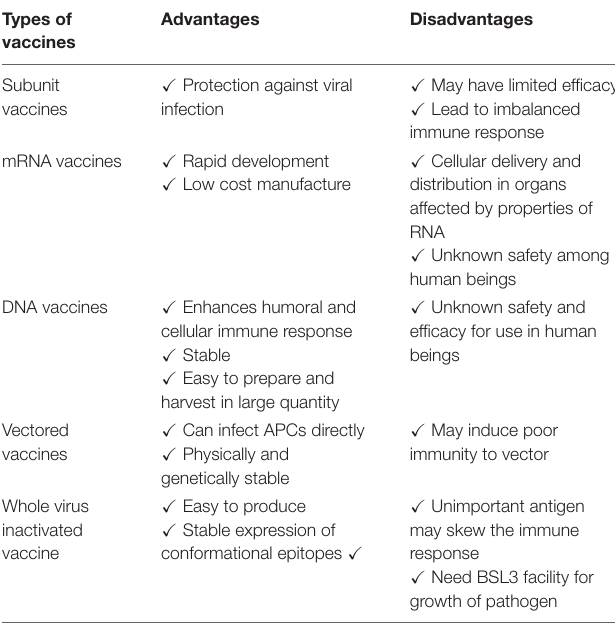
TABLE 5 | Comparison between different approaches to develop SARS-CoV-2 vaccines using S protein or whole virus. Types of